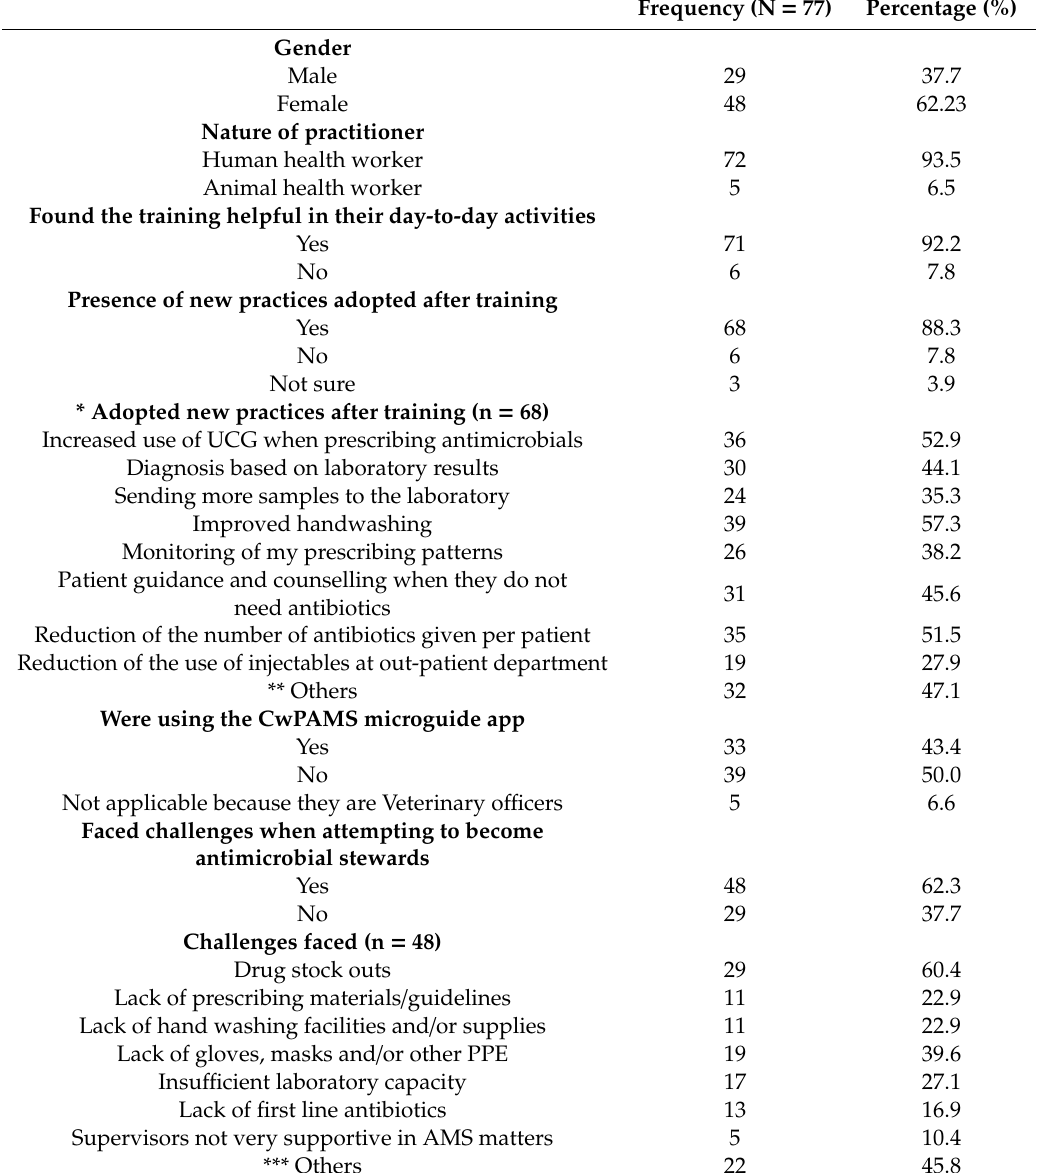
Table 1. Evaluation results of health